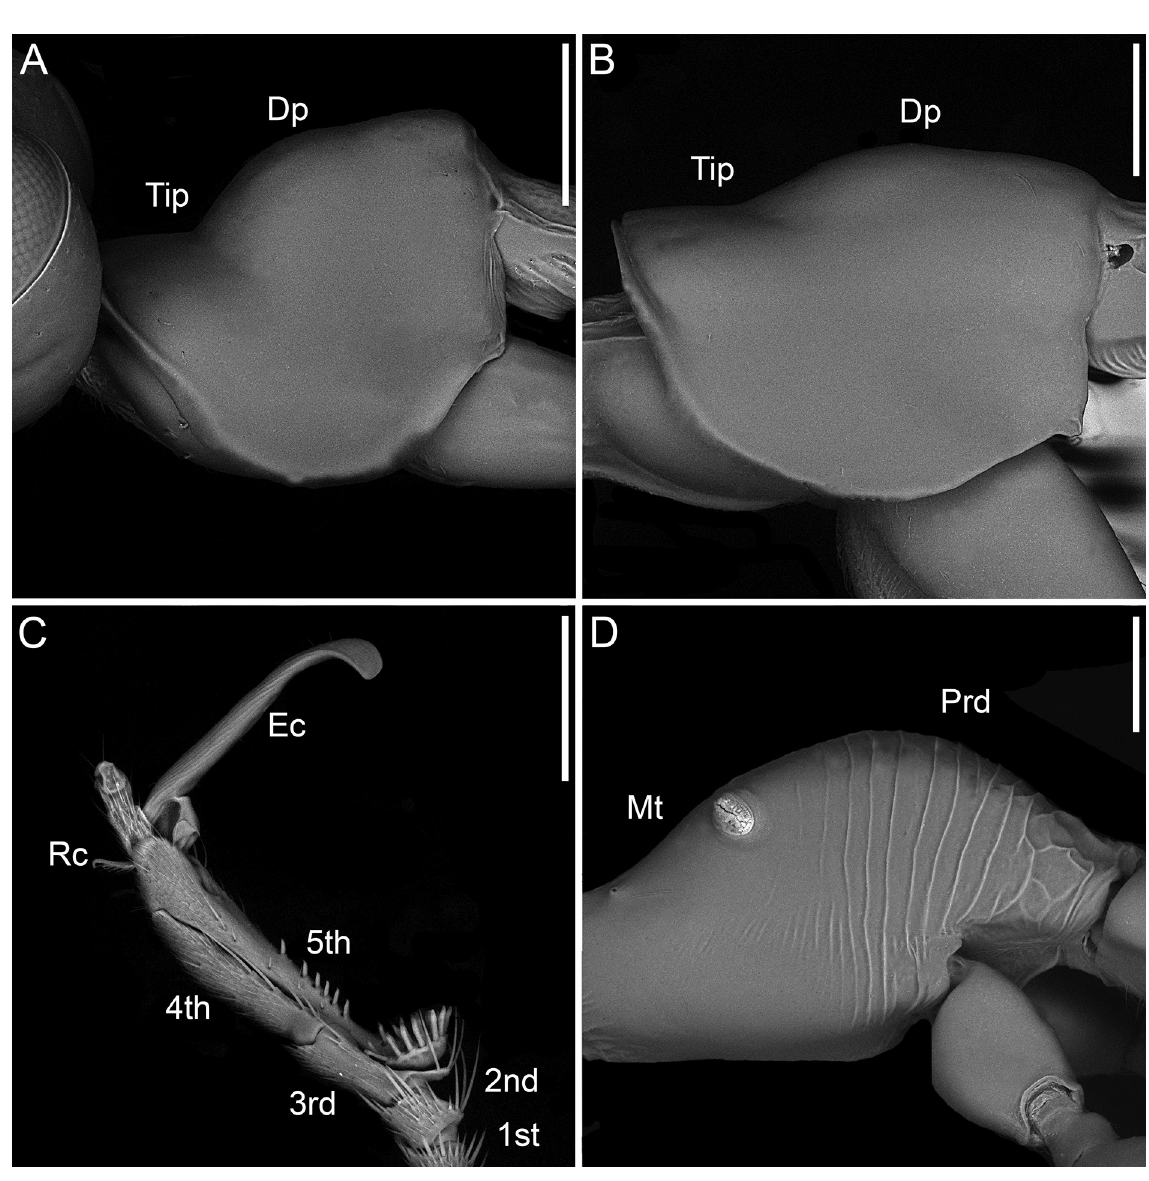
Fig. 2. Electron micrography of external morphology of Pareucamptonyx Olmi, 1991. A . Pronotum of P. kumagaiae Martins sp. nov., lateral view. B . Pronotum of P. paranaensis Martins sp. nov., lateral view. C . Chela of P. kumagaiae sp. nov., lateral view. D . Mesosoma of P. kumagaiae sp. nov., lateral view. Abbreviations: 1 st = first protarsomere; 2 nd = second protarsomere; 3 rd = third protarsomere; 4–5 th = fourth and fifth protarsomeres; Dp = disc of pronotum; Ec = enlarged claw; Mt = metanotum; Prd = propodeum; Rc = rudimentary claw; Tip = transversal impression of pronotum. Scale bars = 200 µm.